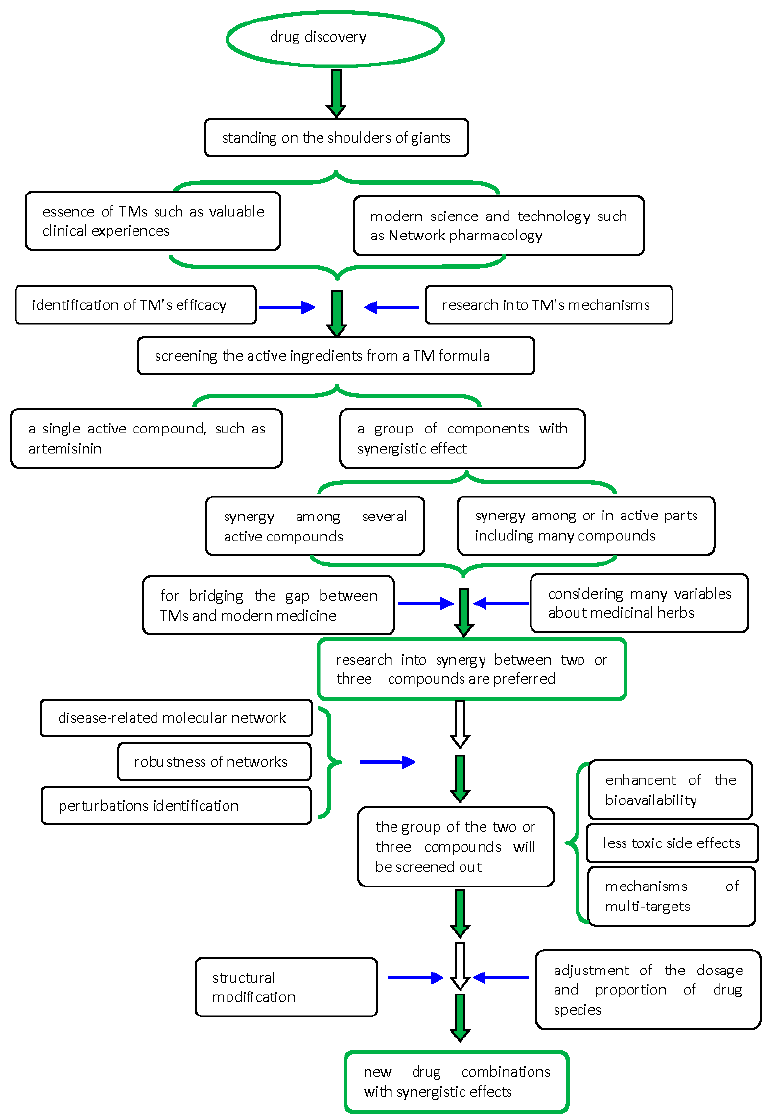
Figure 3. Drug discovery from traditional medicines (TMs).